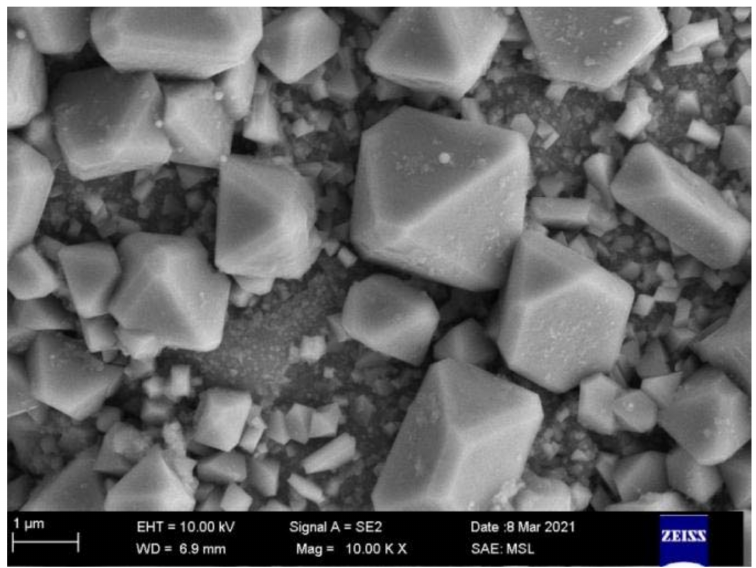
Figure 5. Surface morphologies of the fouling layer at the TSP observed by SEM after 500 h of immersion at 290 ◦